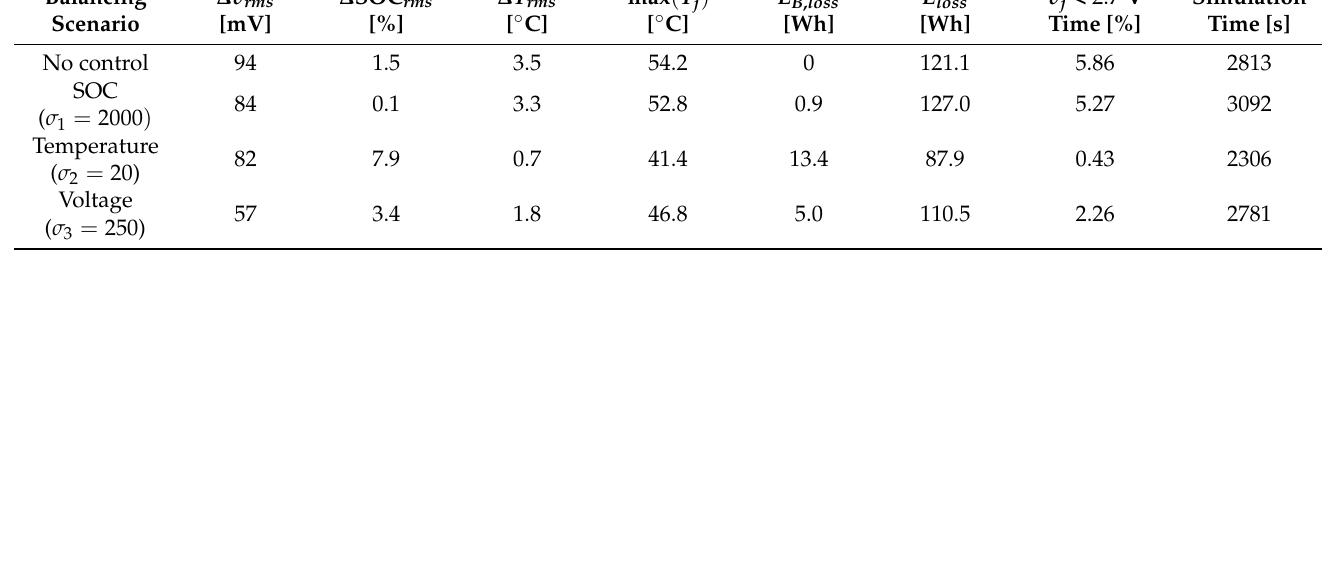
Figure 14. Single controllers result in time. End condition: min agingg, parallel forced air cooling ( h = 15 W/m 2 K).